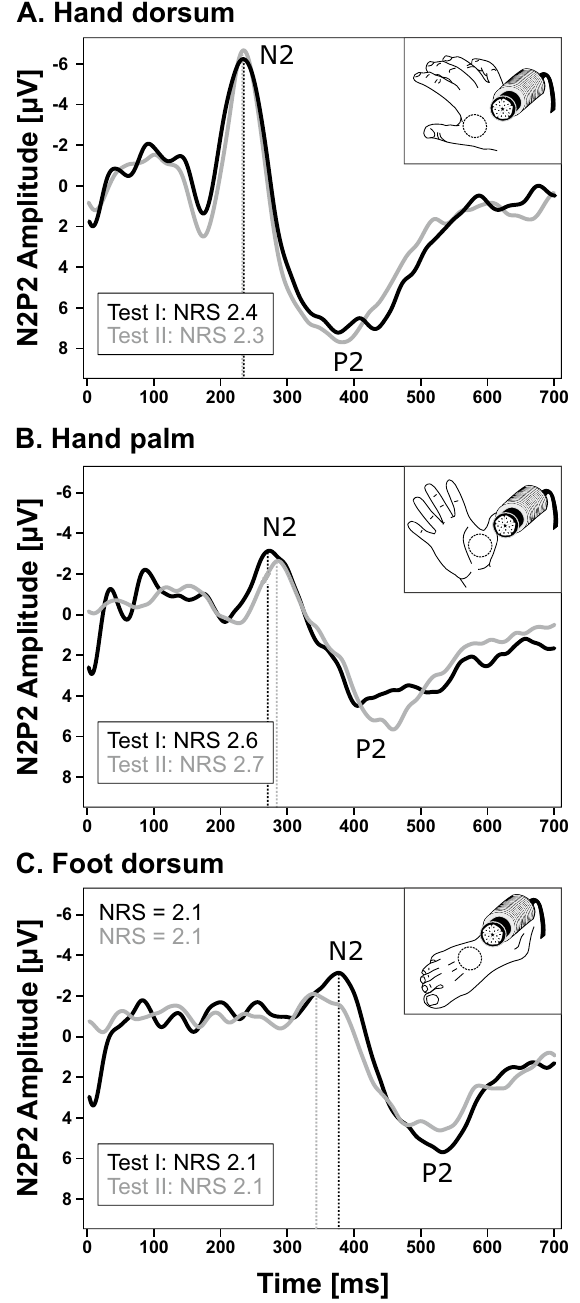
Figure 3. Grand averages of cold evoked potentials. Cold evoked potential negative–positive (N2P2) amplitudes of all individuals after stimulation of the hand dorsum (A) , hand palm (B) , and foot dorsum (C) at test I (black) and test II (grey). NRS numeric rating